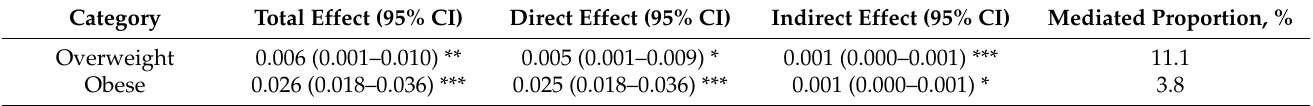
Figure A1. Flow chart presenting the participant’s recruitment. Table A1. Mediation effects of high mTG levels on the association between pre-pregnancy over- weight/obesity and fetal macrosomia, when mTG levels were divided using the 80th percentile as the cut-off point.